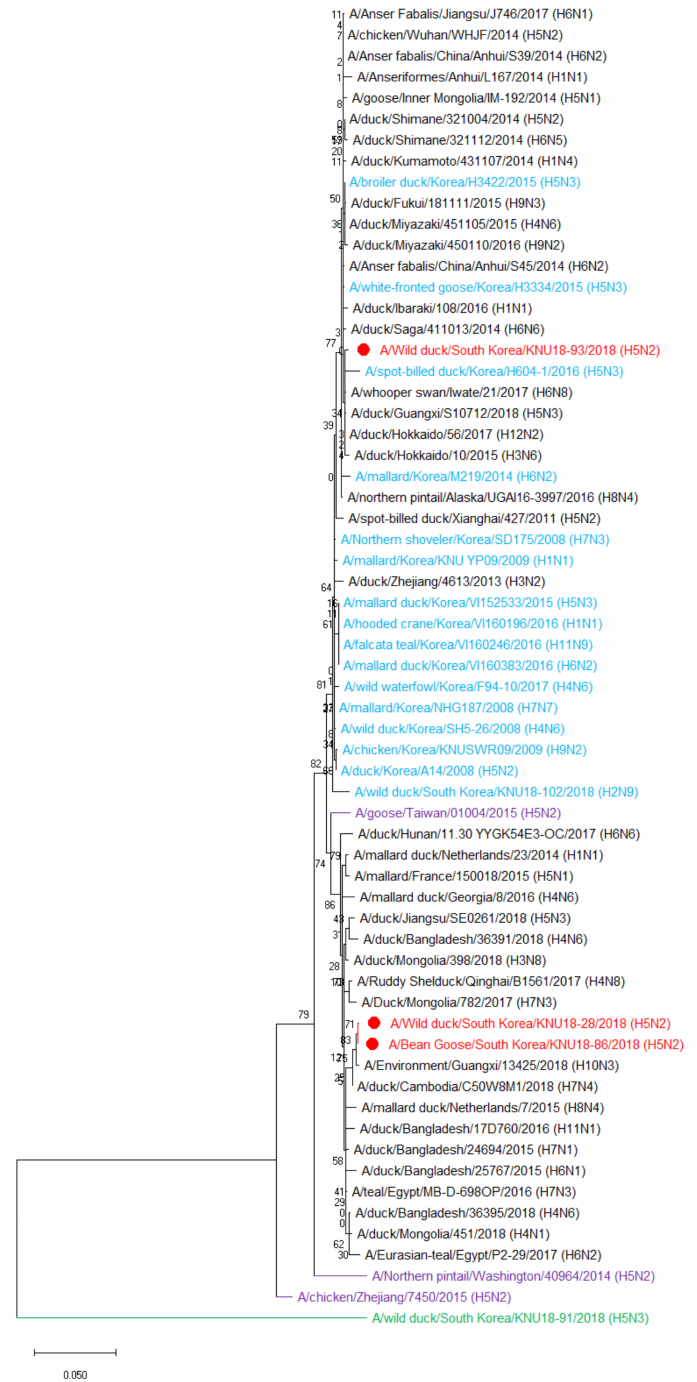
Figure 2. Phylogenetic tree analysis of NS gene segment based on the nucleotide sequences. MEGA-X software using maximum likelihood method with bootstrap replication (1000 bootstraps) was used to generate the phylogenetic tree. Red color: novel H5N2 isolates, blue color: Korean strains, purple color: H5N2 highly pathogenic avian influenza viruses (HPAIVs), and green color: H5N3 strain isolated at the same surveillance